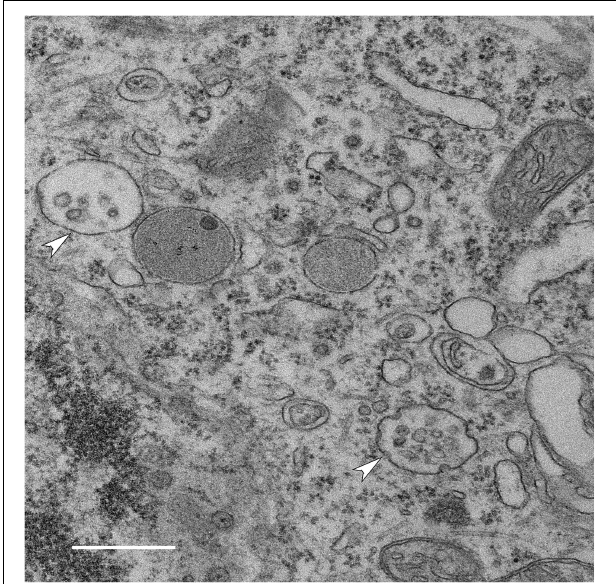
FIGURE 1 | Generation of intraluminal vesicles (ILVs) within MVBs in a neuron. Electron micrograph of MVBs (arrowheads) in a neuron in the brain of a wild-type mouse (bar 500 nm) shows multiple ILVs along with invaginations of the MVB limiting membrane that are likely to represent the formation of nascent ILVs. Once released into the extracellular space, these ILVs are